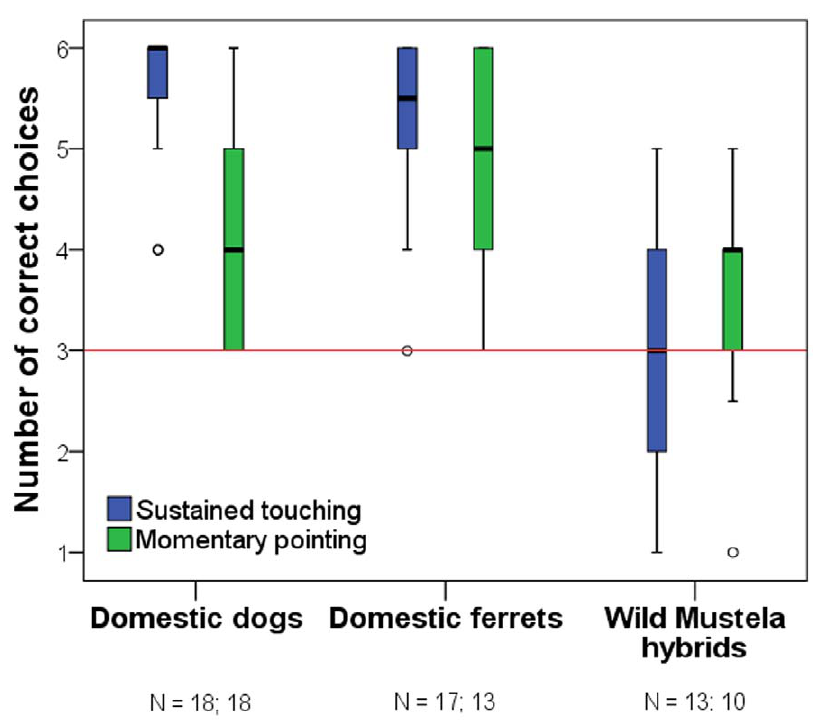
Figure 3. Correct choices out of six trials in the two choice situations based on directional signals. In the sustained touching trials the subject was released while the experimenter was still touching the hiding place. In the momentary pointing trials the experimenter withdraw her hand following the pointing gesture before the subject was released to make a choice. Red line represents chance performance. (***: p , 0.001, **: p , 0.01, ns.: p . 0.05; median, quartiles, whiskers and outliers).